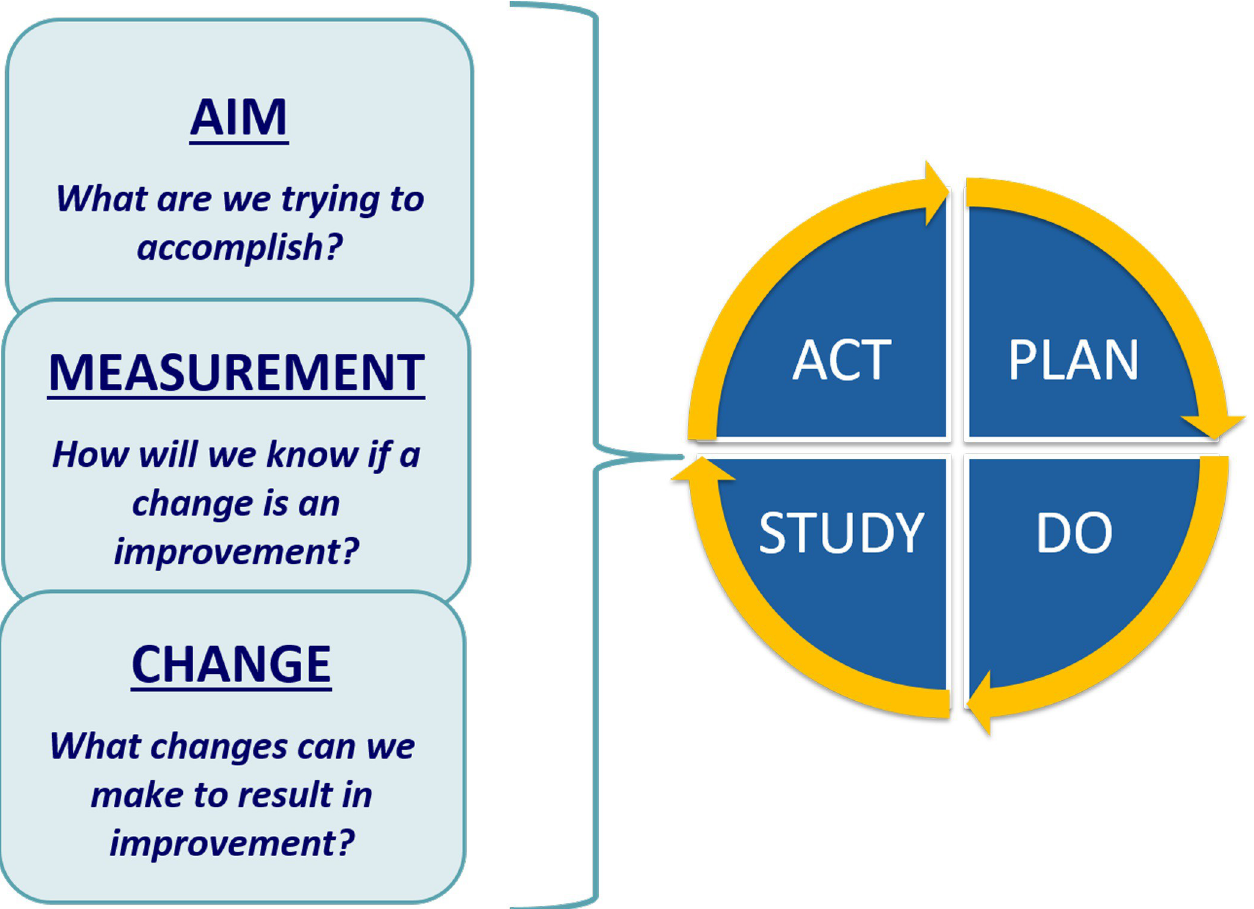
Fig 1. Model for improvement: Adapted from: Langley G, Nolan T, Norman C, Provost L (1996). The Improvement Guide. A practical approach to enhancing organizational performance.